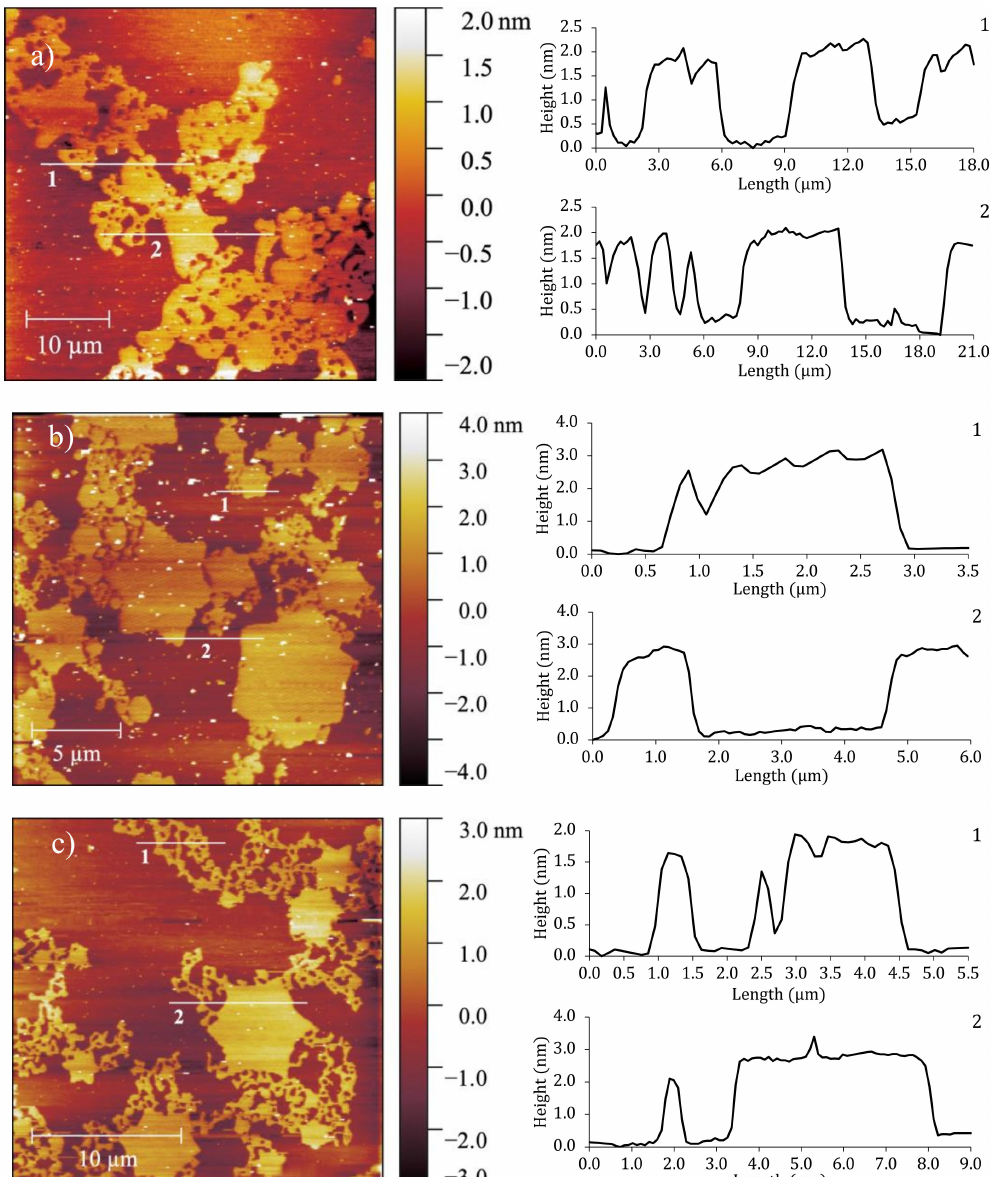
Figure 4. AFM height images of ( a ) F14OH at 0.7 nm 2 / molecule, ( b ) F18OH at 0.85 nm 2 / molecule and ( c ) (20:80) molar mixture of F14OH + F18OH at 0.8 nm 2 / molecule. The right panels show the height profiles along the numbered lines on the AFM